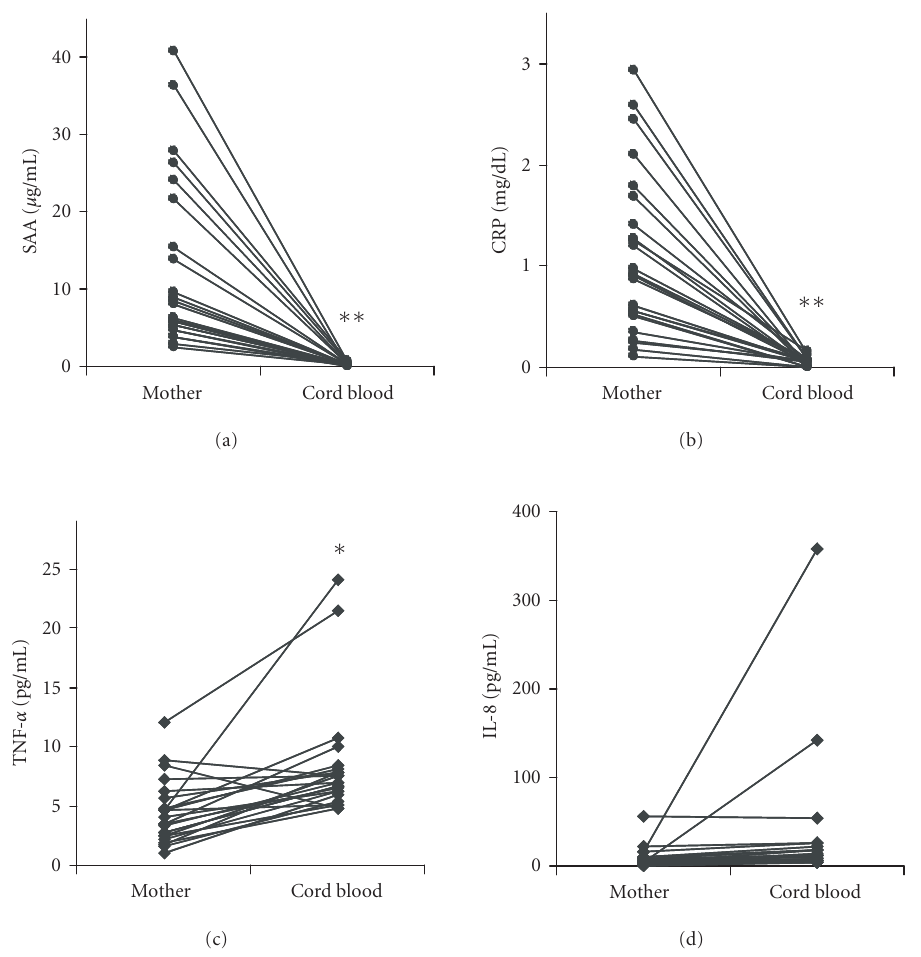
Figure 1. Concentration of SAA, CRP, TNF- α , and IL-8 in maternal and umbilical cord blood at delivery. The lines link values found in individual cases. ( ∗ denotes that P < . 05 and ∗∗ denotes that P < . 001 for comparisons between the mother and cord blood